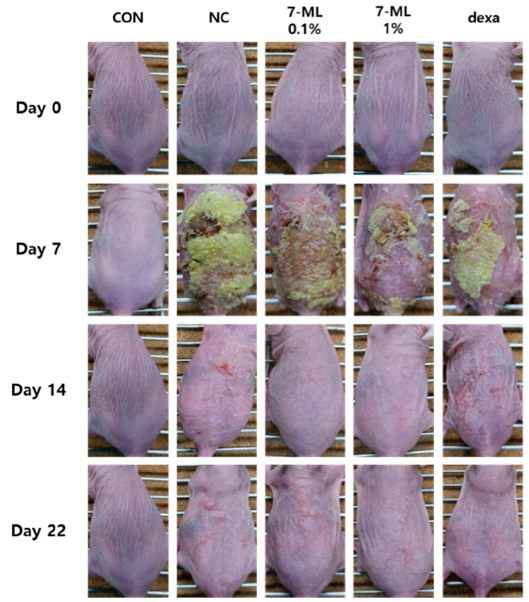
Figure 3. Effects of 7-ML on atopic dermatitis-like symptoms in the DNCB-induced mouse model. Photographs of the AD-like skin symptoms exhibited by SKH-1 hairless mice were evaluated during the 3-week experimental period. CON, nontreated control; NC, DNCB-treated negative control; 0.1% or 1% 7-ML, DNCB + 0.1% or 1% 7-ML-treated groups; dexa, DNCB + dexamethasone-treated group.